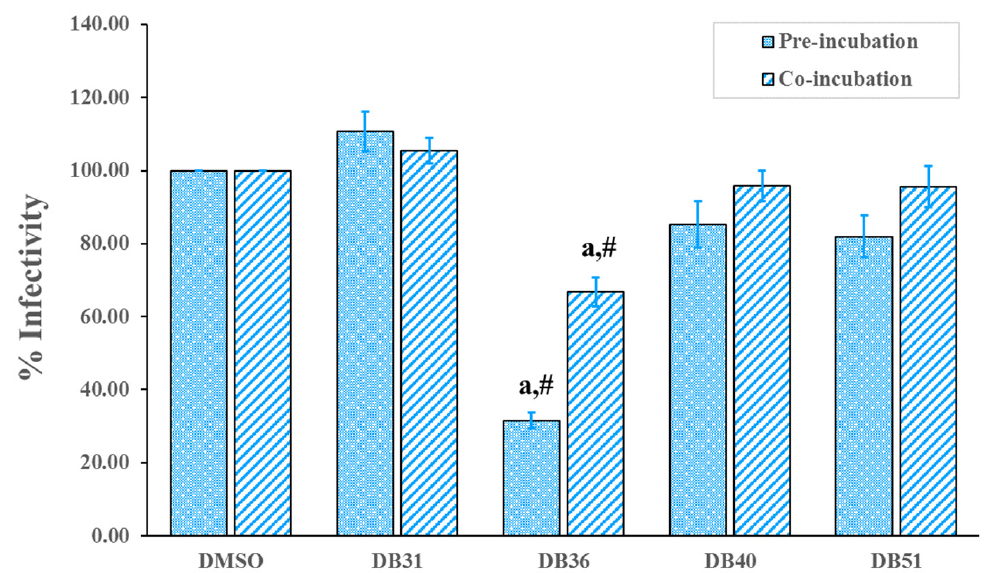
Figure 4. Screening of hit compounds against pseudovirion (SARS-CoV-2 S pseudotyped HIV) infection to host cells, HEK293T, at a concentration of 12.50 µ M with the exception of DB31 at a concentration of 3.12 µ M. Confluent HEK293T/17-hACE2 cells overexpressing hTMPRSS2 were incubated with pseudovirion and hit compounds in pre-incubation conditions (virus and the hit compound incubated for one hour before infected to the cell) or co-incubation (virus and the hit compound immediately infected to the cells). BS-R2B2 (MonoRab SARS-CoV-2 neutralizing antibody) at 1 µ g/mL was used as a positive control. The percentage of infectivity of each bar presented the percentage of SARS-CoV-2 S-hACE2 mediated infectivity as mean ± SEM ( n = 3). The letter ‘a’ denotes a significant difference compared with the control DMSO ( p < 0.05), and the symbol ‘#’ denotes a significant difference between pre- and co-incubation of each compound, based on one-way ANOVA using GraphPad Prism 5.02.